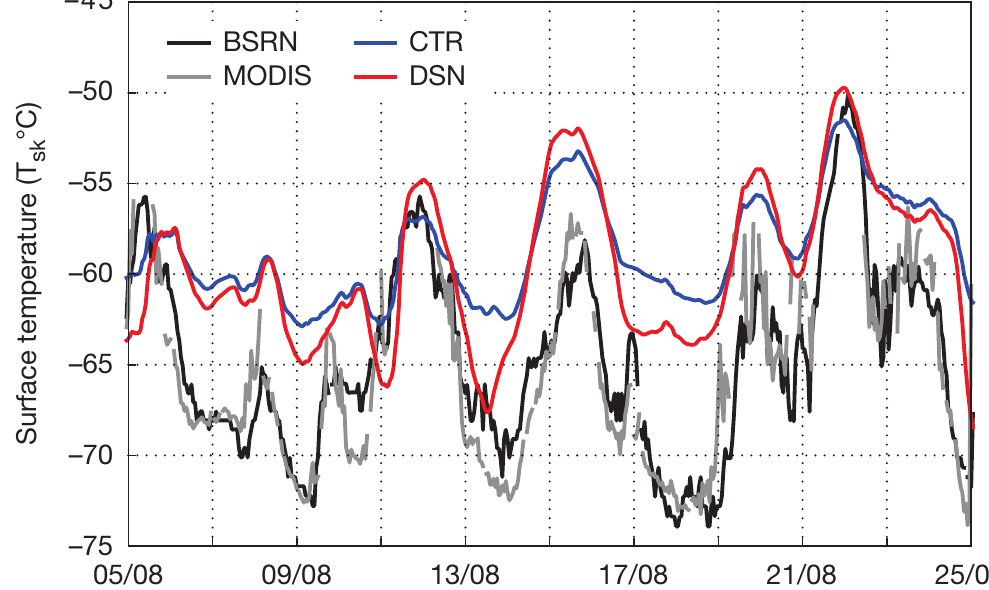
Figure 10. Time-series of the land surface (skin) temperature (LST, Celsius) at the south-pole for in situ observations (BRSN), MODIS satellite data (MODIS), numerical experiment with the bulk (single-layer) snow scheme (CTR) and numerical experiment with the thermal depth of the snow reduced by a factor of 10 (DSN), the latter being a proxy for the potential impact of a multi-layer snow scheme. It is clear that DSN has a larger amplitude LST diurnal cycle than CTR, and a better representation of strong cooling events